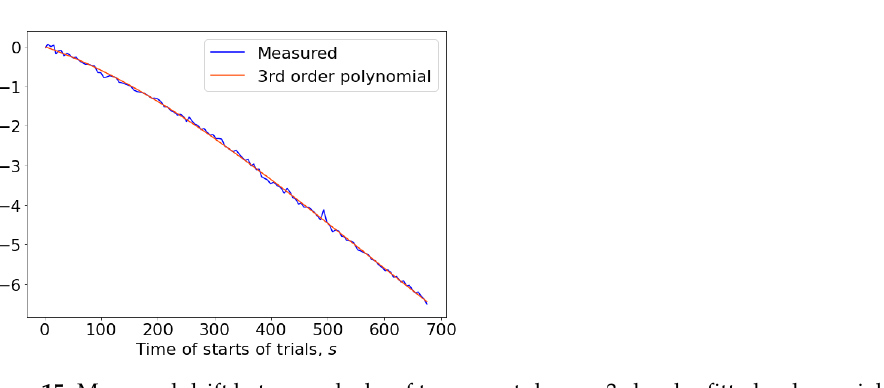
Figure 15. Measured drift between clocks of two smartphones; 3rd order fitted polynomial is also shown to highlight estimation